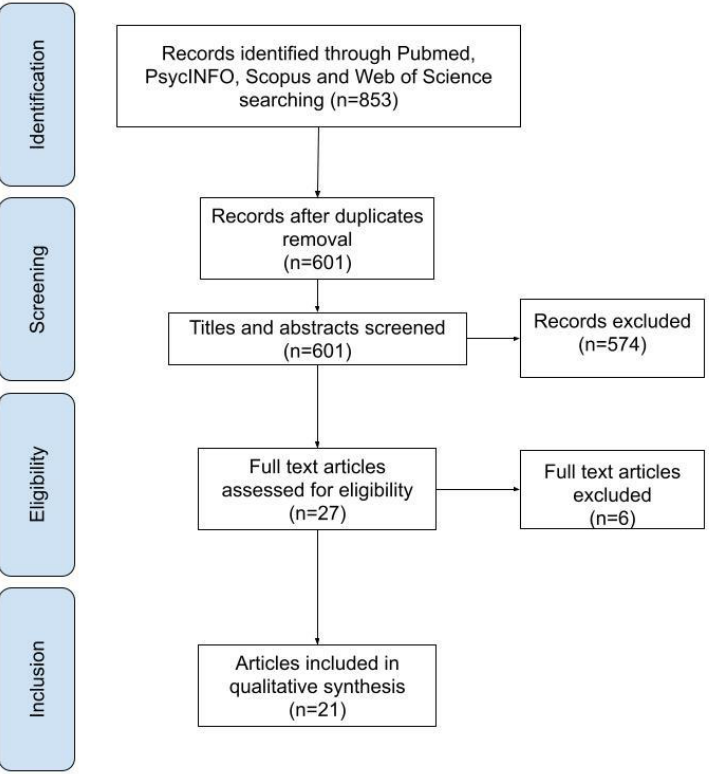
Figure 1. Flow diagram of selection process.